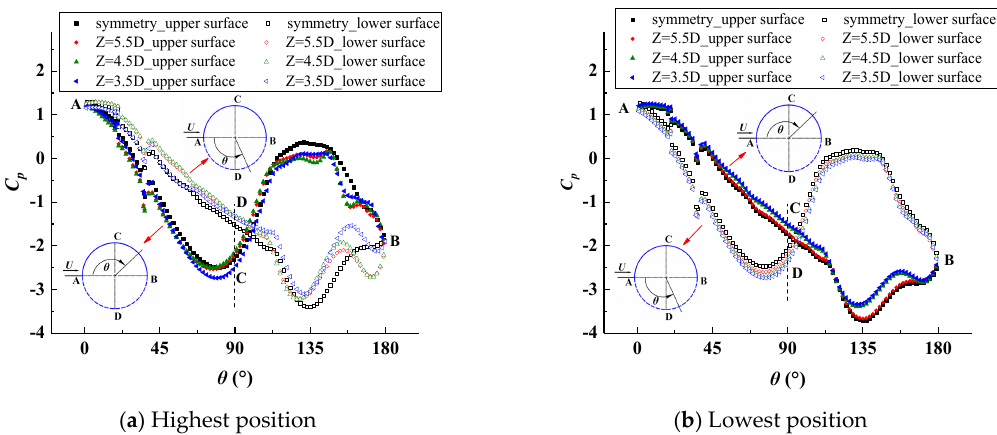
Figure 10. The C p of PTC cylinder in flow induced vibration varies with Z ( Re = 5.3 × 10 4 ).